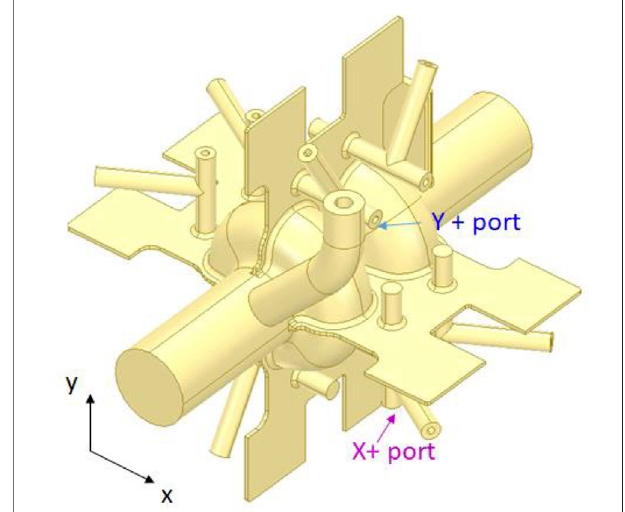
FIGURE 8 | 3D model showing two coaxial HOM ports located on the orthogonal branches of the SWELL cavity